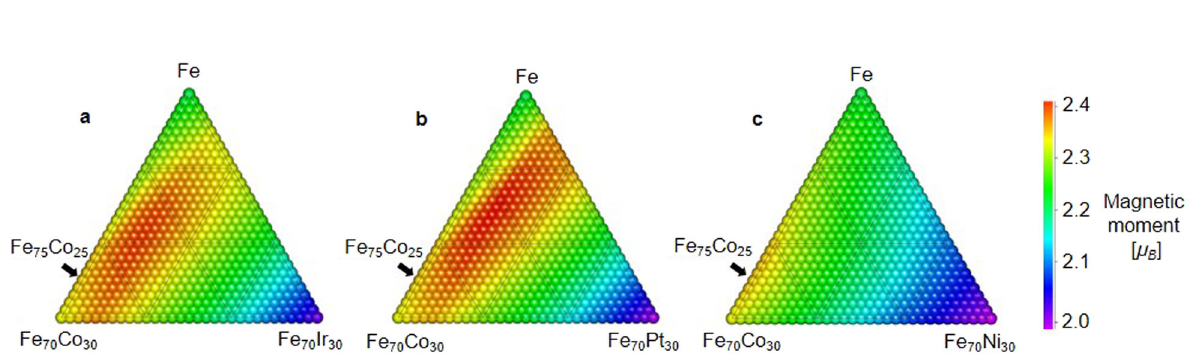
Fig. 4 Theoretical con fi rmation by ab-initio simulation. To con fi rm and analyze the alloy discovered by the autonomous materials search system and combinatorial experiments, the magnetic moments in various ternary alloys were investigated by ab-initio calculation. a Magnetic moments in FeCoIr ternary alloy system (largest magnetic moment was observed for Fe 81 Co 15 Ir 4 ). b Magnetic moments in FeCoPt ternary alloy system (largest magnetic moment was observed for Fe 85 Co 11 Pt 4 ). c Magnetic moments in FeCoNi ternary alloy system (Ni impurities do not enhance magnetic moment, so the largest magnetic moment was observed in the alloy at the top of the Slater – Pauling curve, Fe 75 Co 25 ).